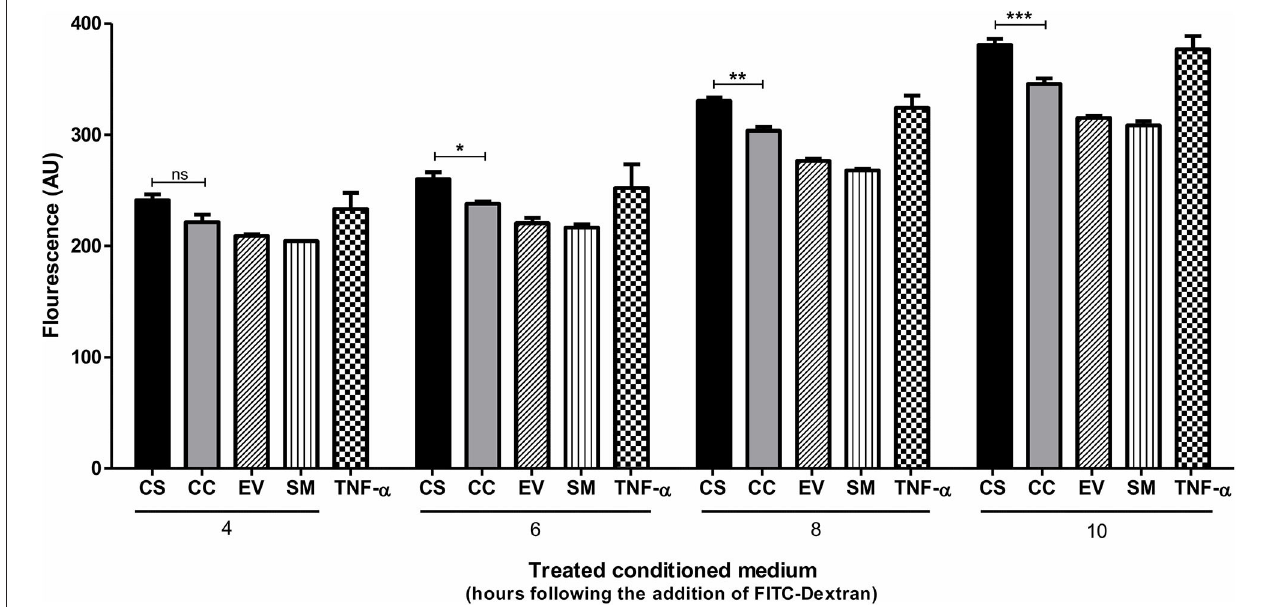
FIGURE 6 | CS-Tat enhances trans-endothelial permeability of FITC-Dextran across the endothelial monolayer. hCMEC/D3 cells were seeded on collagen-coated 0.4- µ m culture inserts and allowed to grow to confluence. The cells were serum-starved for 12h before the assay. Jurkat-Tat-conditioned media collected at 12h following dox induction were added to the confluent hCMEC/D3 monolayer on the inserts and the wells. Following 24h of incubation at 37 ◦ C, a fresh medium supplemented with FITC dextran (0.1 µ g/ml) was added apically to the inserts. Culture media were collected from the wells at regular intervals and monitored for fluorescence. hCMEC/D3 cells treated with 10ng/ml of TNF- α served as the positive control in the assay. The data are representative of three independent experiments. Two-way ANOVA with Bonferroni post-test was used for the statistical evaluation (* p < 0.05, ** p < 0.01, *** p < 0.001 and ns,